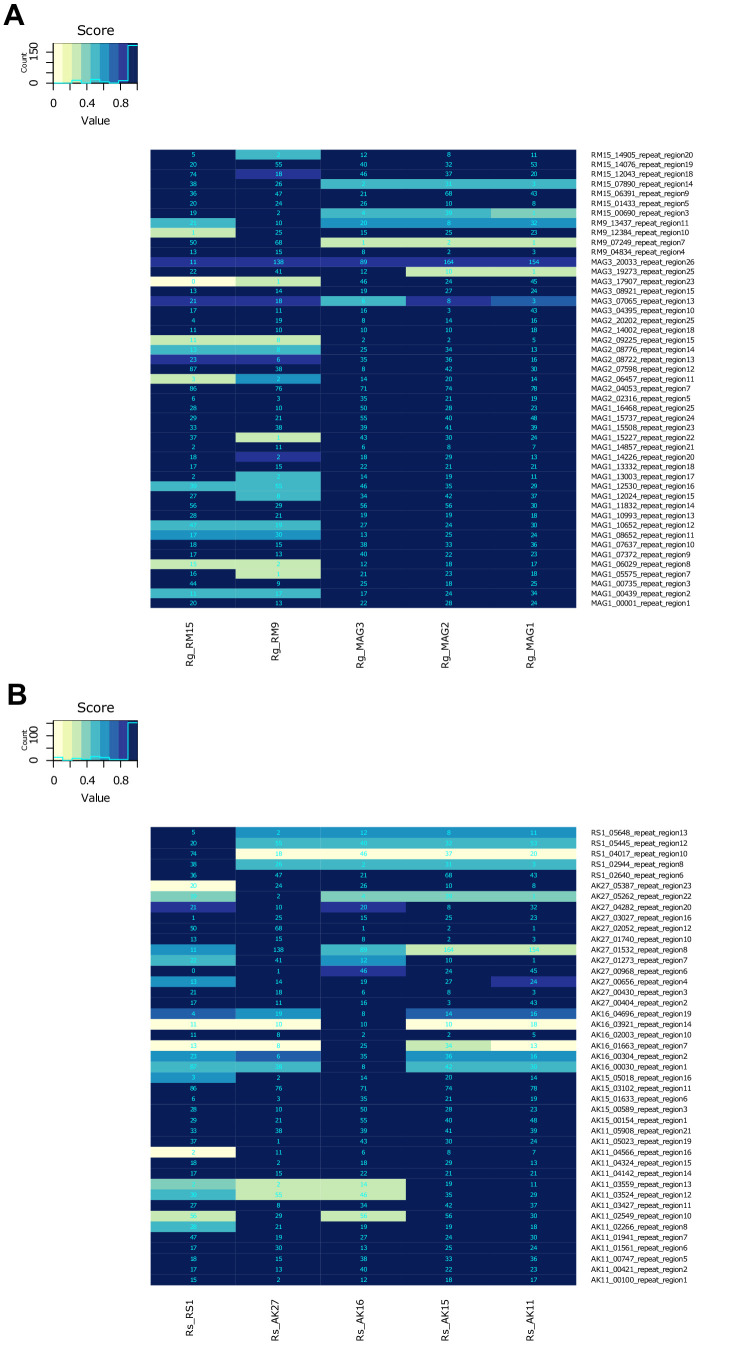
LTR-R polymorphism details.Data are shown for (A) R. magnacalcarata and (B) R. socialis. Numbers in cells indicate the number of reads mapped to the LTR-tag location (see Materials and methods).